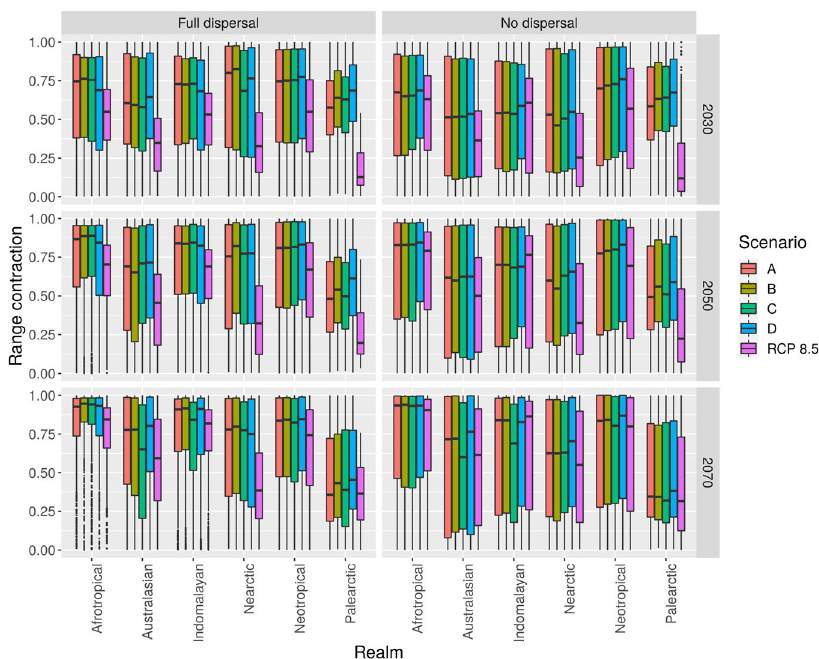
Fig. 1 Boxplots of projected range contractions for amphibian species. Boxplots of projected range contractions for amphibian species contracting their ranges under a high-emissions scenario (RCP8.5; reference scenario) and a high-emissions scenario with four hosing experiments adding 0.11, 0.22, 0.34, and 0.68-Sv of freshwater (1 Sv = 10 6 m 3 /s) labeled as A, B, C, and D, respectively. The number of species contracting their ranges varied across scenarios, time horizon, niche modeling algorithms, and realms (955 – 2068; Tables S2 – S3). Range contractions are expressed in proportional terms and are shown for two dispersal scenarios (full dispersal and no dispersal). Results were averaged across three ecological niche modeling algorithms (MaxEnt, BRT, CART; see “ Methods ” ) and compared across six biogeographic